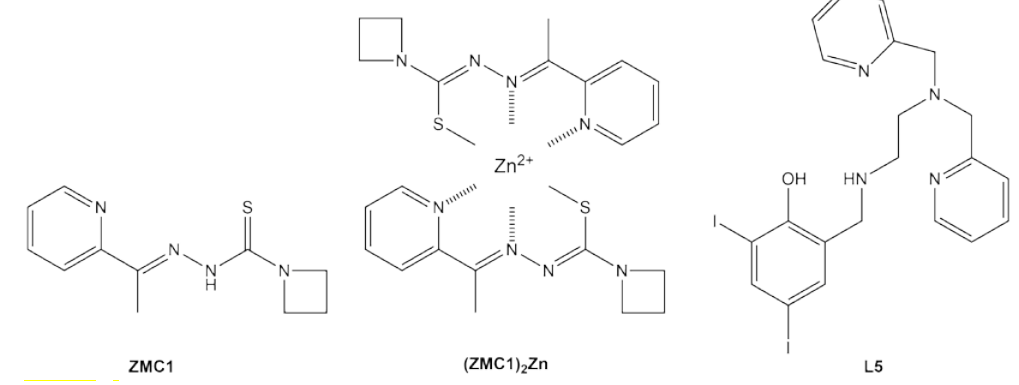
Figure 3. Metallochaperones that target the zinc-binding and stability class mutants of p53.